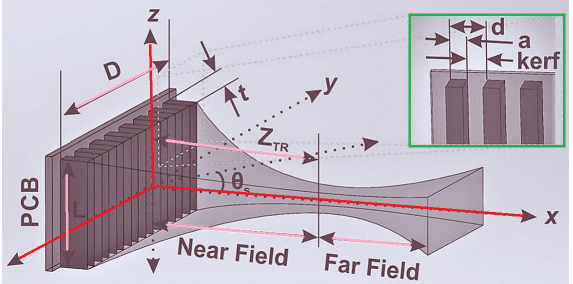
Figure 25. A linear phased array with a conceptual beam shape.